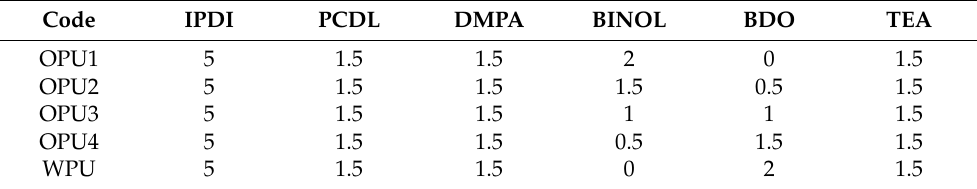
Table 3. Molar ratio of each component for WPU and